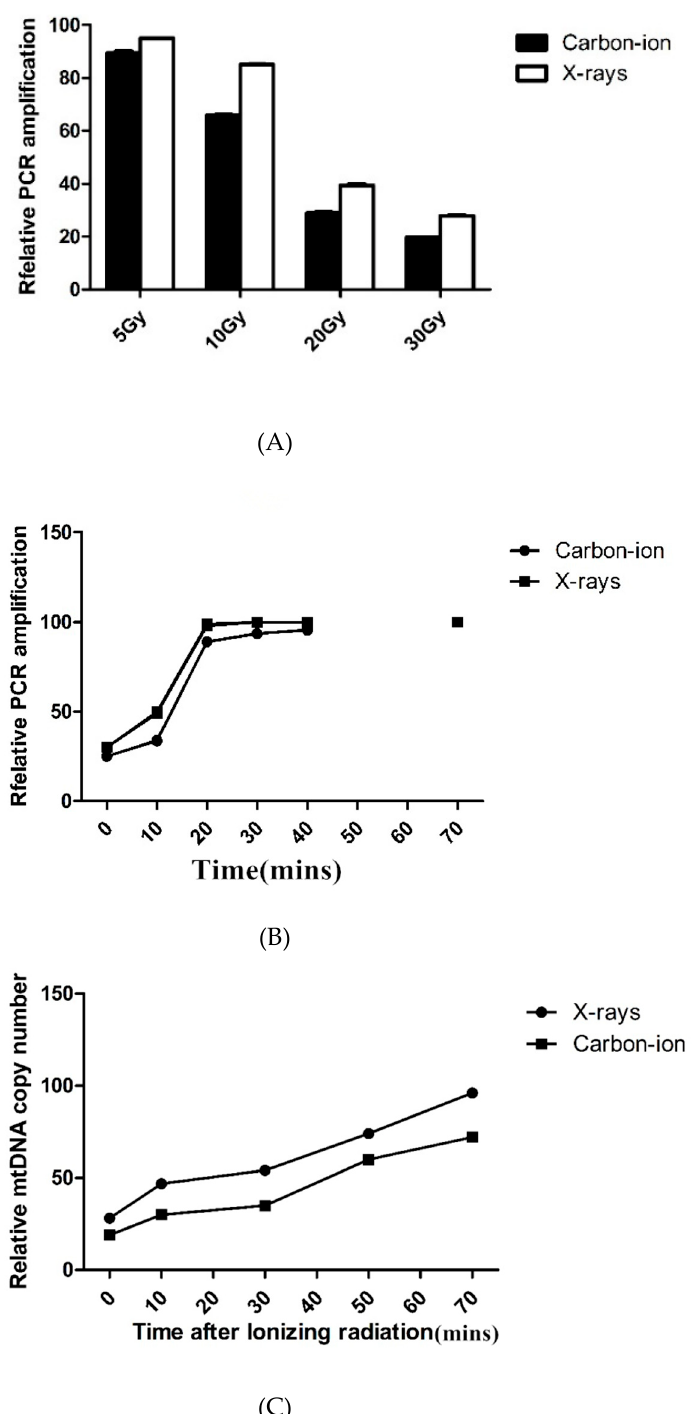
Figure 2. ( A ) DNA damage repair and mtDNA copy number in irradiated hydatid cysts. Quantification of mtDNA (mitochondrial DNA) damage by long-PCRamplification of total DNA isolated from E. granulosus hydatid cysts after 5–30 Gy X-rays or carbon-ion radiation. MtDNA damage was indicated by reduced PCR amplification. ( B ) DNA damage repair and mtDNA copy number in irradiated hydatid cysts. Repair kinetics of mtDNA in E. granulosus hydatid cysts within 72 h after 30 Gy X-rays or carbon-ion radiation. ( C ) DNA damage repair and mtDNA copy number in irradiated hydatid cysts. Quantification of mtDNA copy number by real-time PCR.